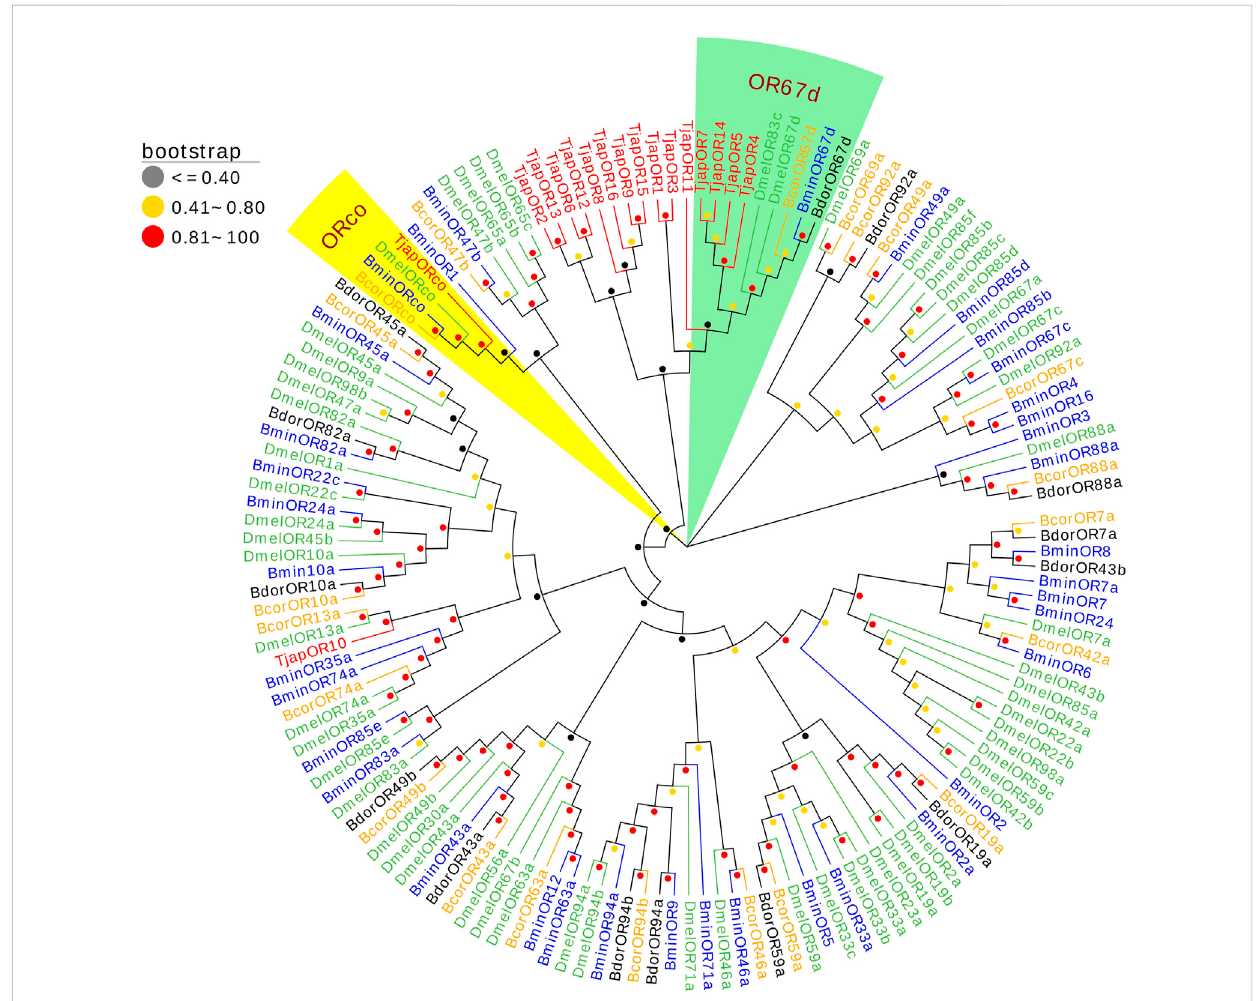
FIGURE 3 The NJ phylogenetic analysis of ORs in T. japonensis , B. minax , B. correcta , B. dorsalis , and D. melanogaster . The ORco group and OR67d group are shown.